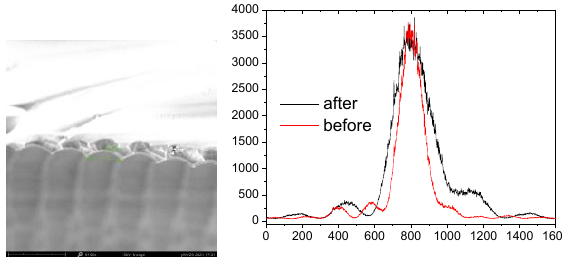
Fig. 3 Left: HCW profile along the channel, showing ripples of about 5 mm period. Right: Beam profile at fiber exit before and after thermal treatment, arbitrary units on both